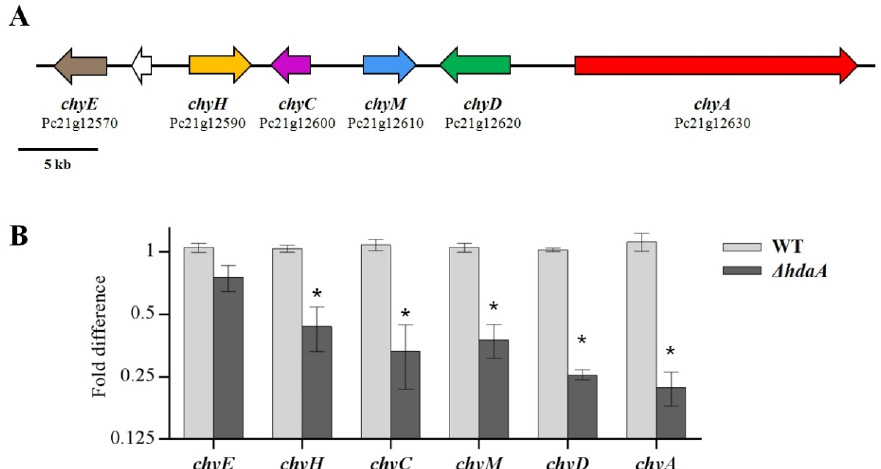
Figure 4. Transcriptional analysis of the chrysogine biosynthetic gene cluster. ( A ) Organization of the chrysogine biosynthetic gene cluster (BGC). ( B ) Quantitative RT-PCR analysis of the chrysogine BGC.